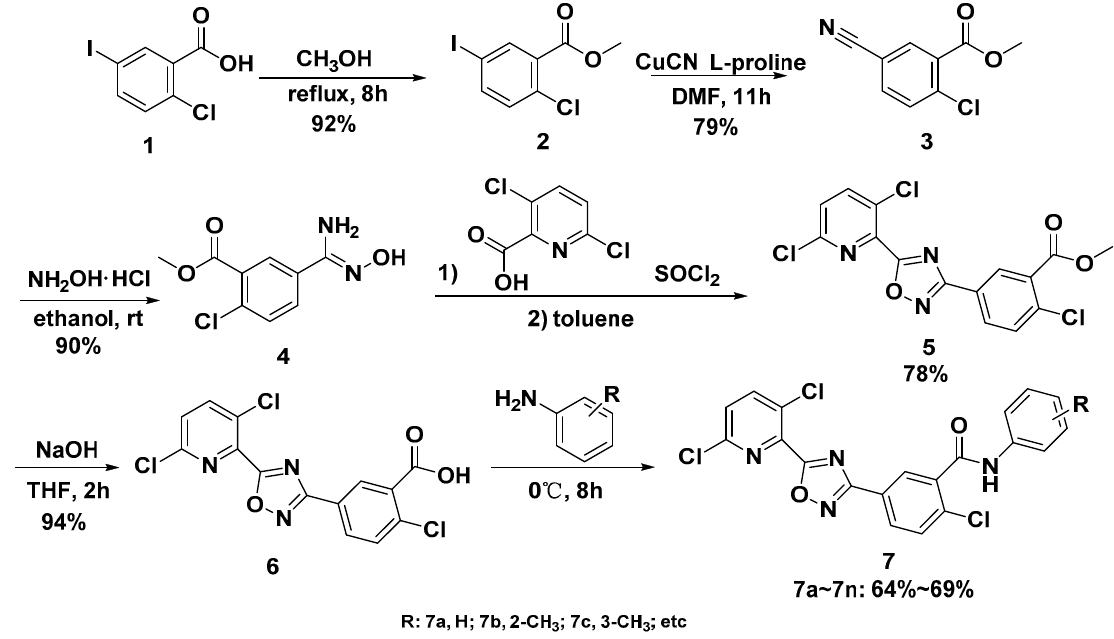
Scheme 1. Synthetic route of target compound 7 .